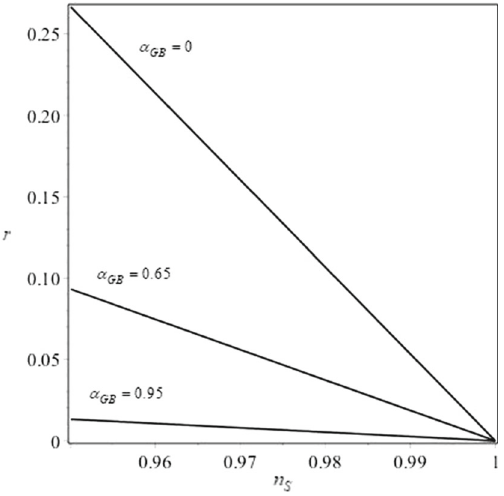
Fig. 1 The r = r ( n S ) diagram for different values of the coupling constant α